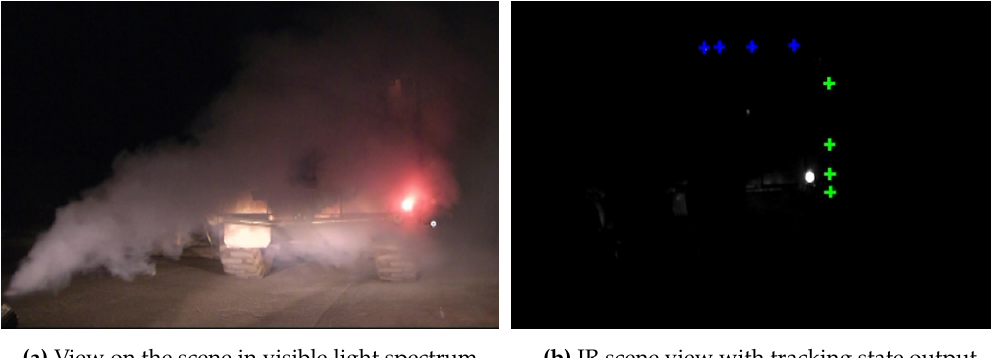
Figure 34. Both targets’ models are fully identified and tracked during fog tests.